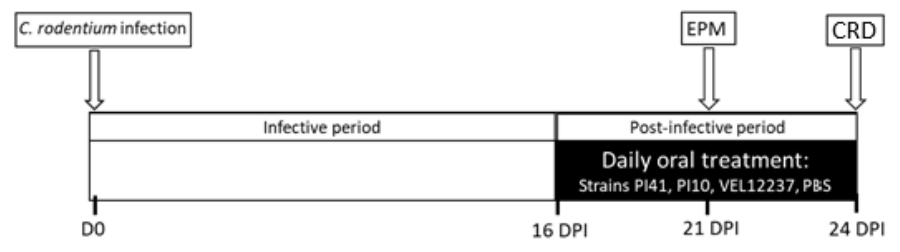
Figure 2. Protocol of the post infectious IBS model. DPI—days post infection; CRD—colorectal distension; EPM—Elevated Plus Maze test.